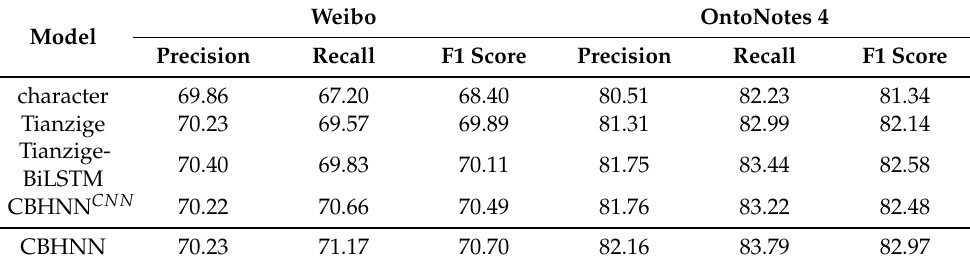
Table 10. Result of CGR-NER with different glyph